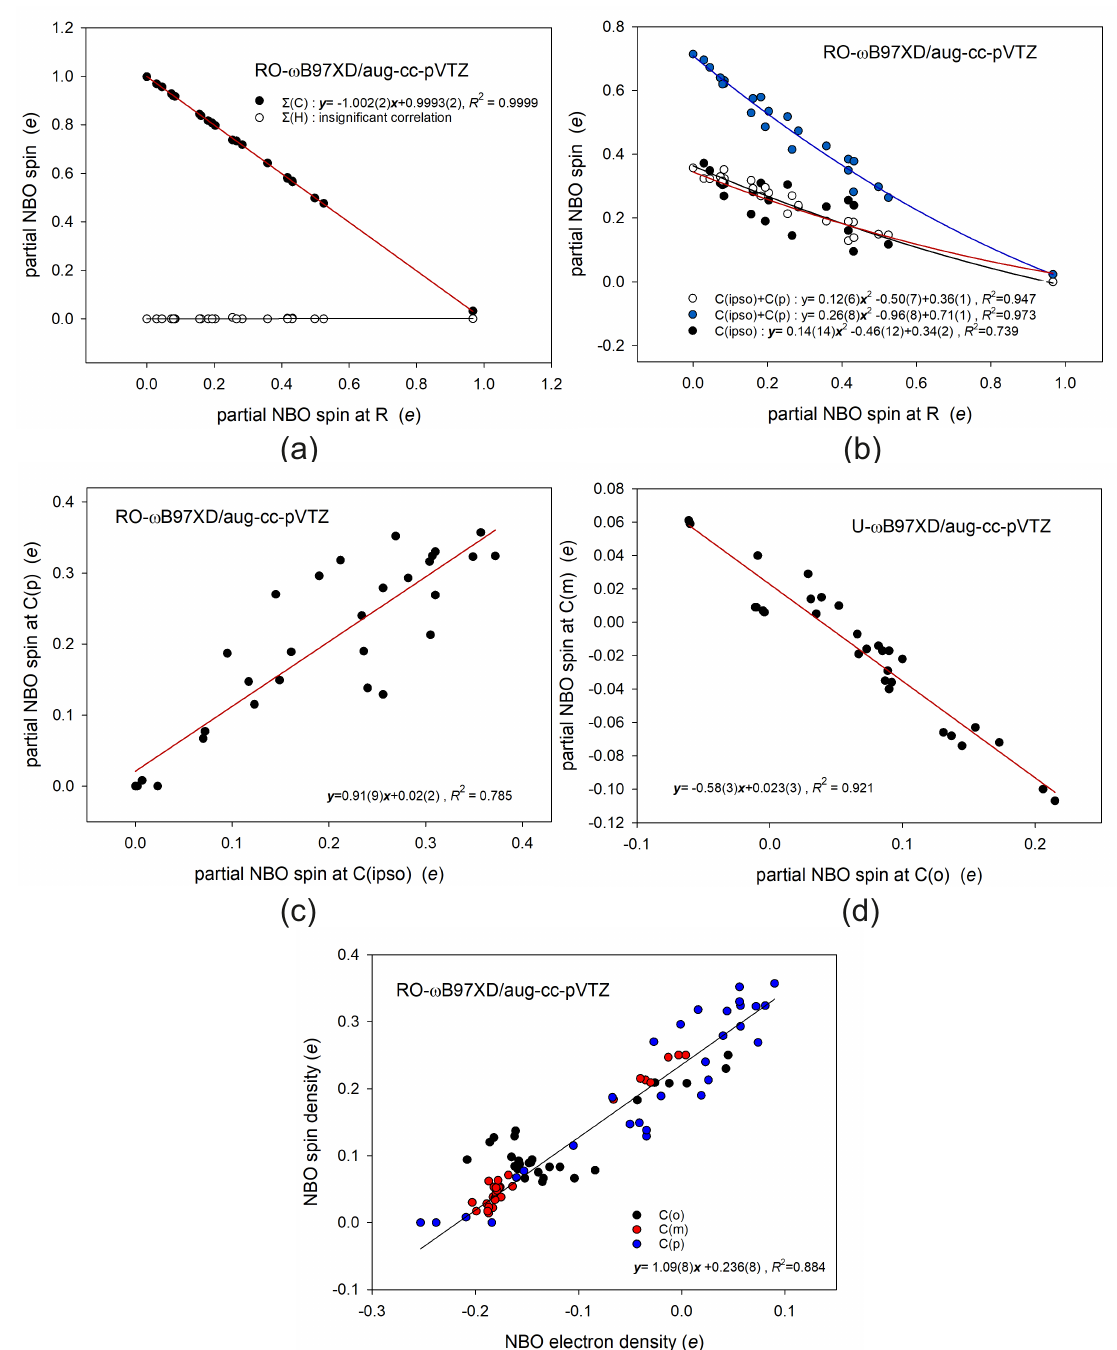
Figure 5. ( a ) Linear changes in the sum of the partial NBO spins at the ring C atoms, Σ (C), and lack of similar changes at the sum of ring H atoms, Σ (H), in the monosubstituted benzene cation radicals with the partial spin at all R substituent atoms. ( b ) Slightly nonlinear correlations of the partial NBO spin at the sum of C(ipso) and C(p) atoms with the partial spin at R and similar, but weaker, correlations for separate C(ipso) and C(p) atoms. ( c ) A fair linear correlation between partial spin located at C(ipso) and C(p) atoms calculated using RO-DFT method. ( d ) A significant linear correlation between partial spin located at C(o) and C(m) atoms calculated using the U-DFT method. All atypical systems (forms (II) and (e)) were omitted in correlations. ( e ) The correlation between NBO electron density and NBO spin density at the ring C